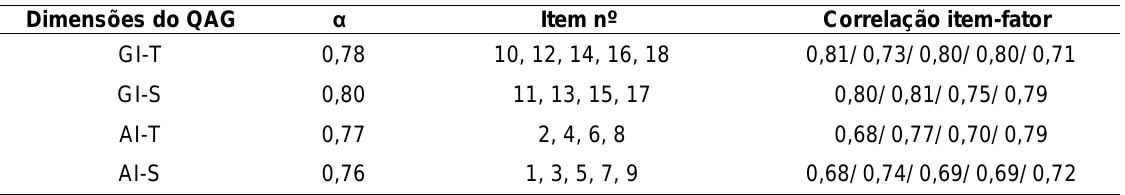
Tabela 2. Consistência interna das dimensões da versão brasileira do Group Environment Questionnaire (GEQ) e correlação